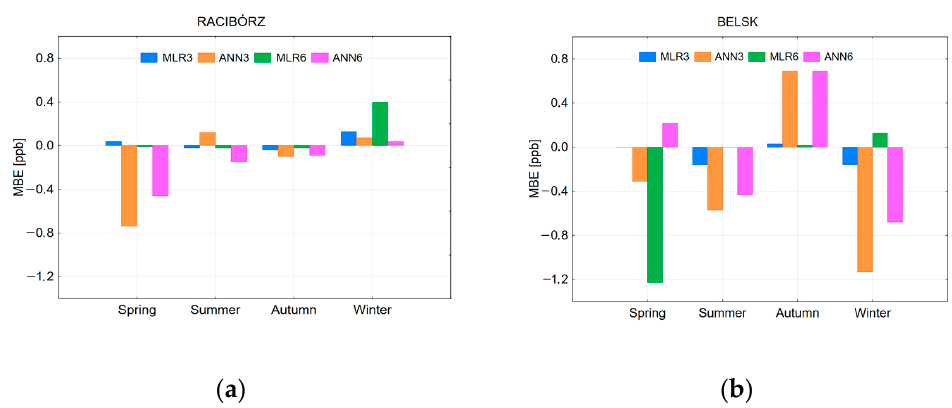
Figure 9. The same as Figure 8 but for mean bias error (MBE) for Racibórz ( a ) and Belsk ( b ).